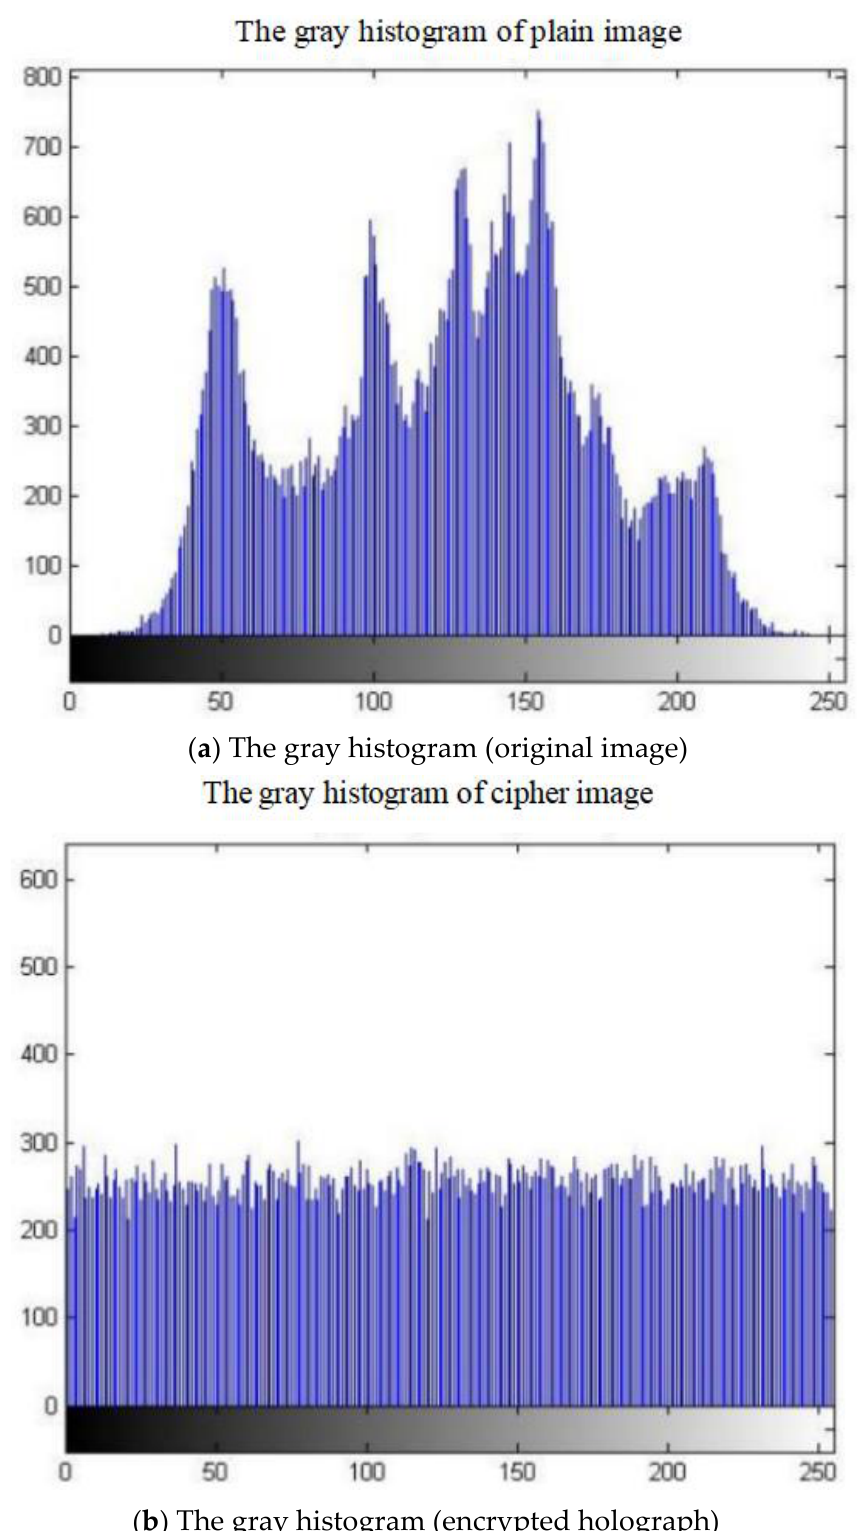
Figure 5. Gray histogram analysis.